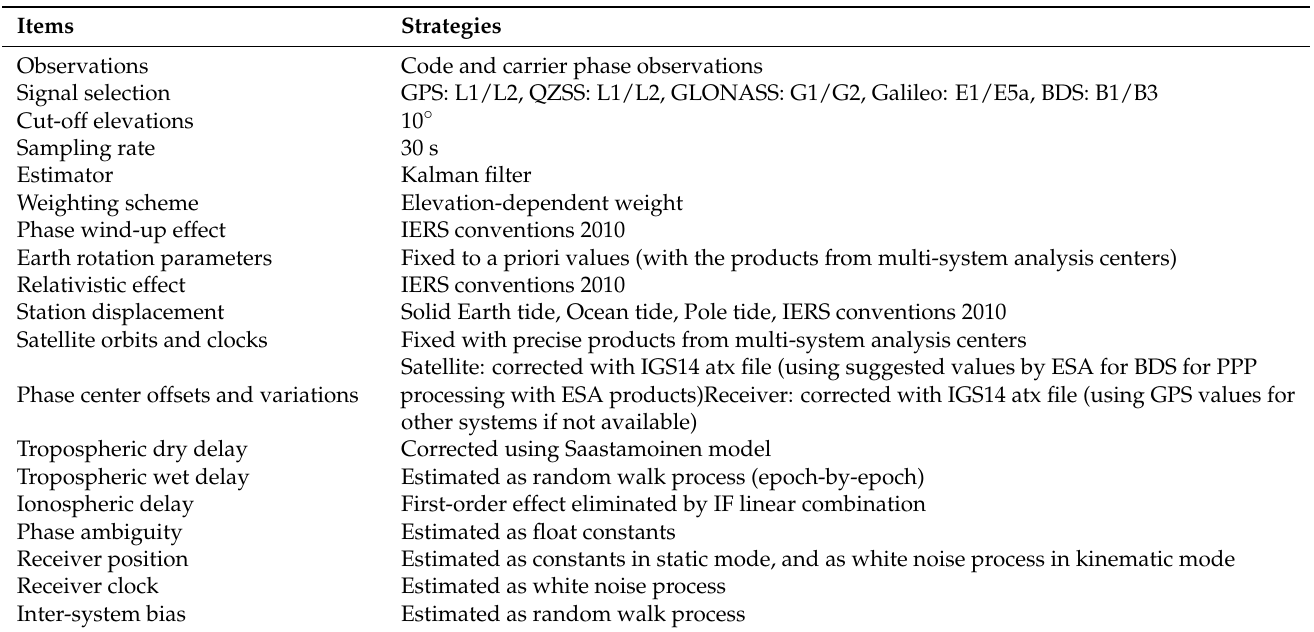
Table 8. Processing strategies for